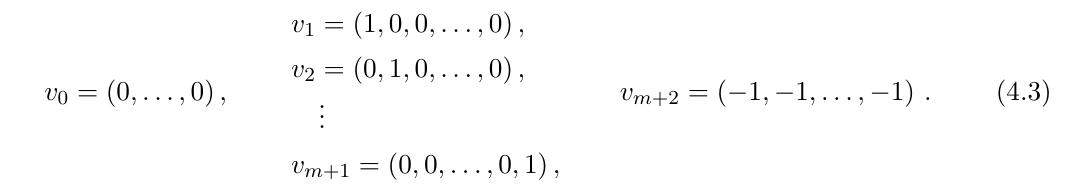
Figure 2 . Toric diagrams for F ( m )